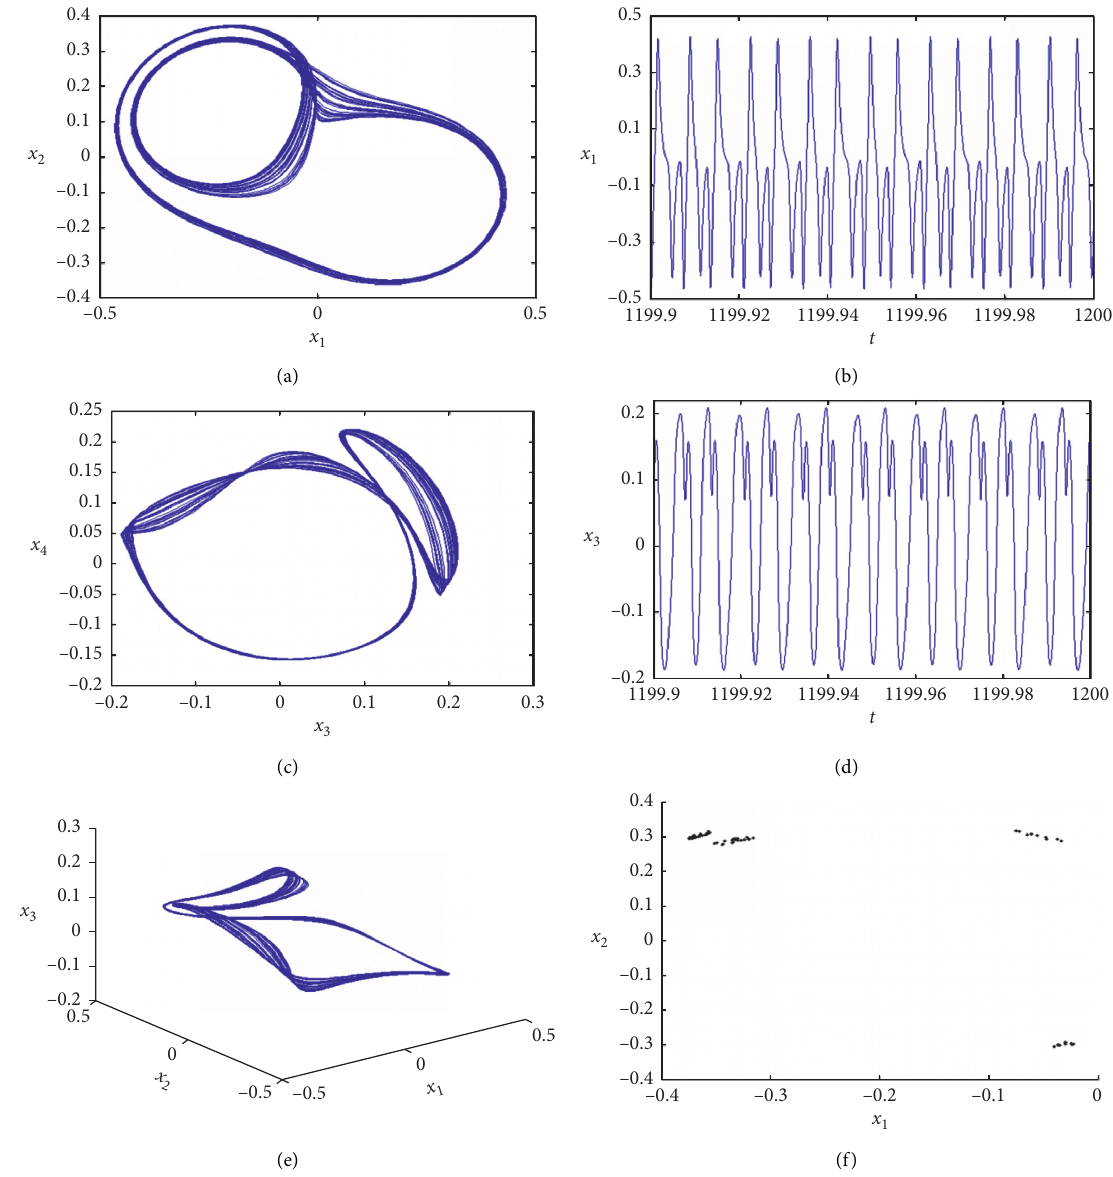
Figure 11: The multiperiodic oscillation of the cantilevered pipe conveying pulsating fluid is obtained when the parametric excitation of the � 23 . 2. (a) Phase portrait on plane ( x ,x ) , (b) waveform on plane ( t,x ) , (c) phase portrait on plane ( x , x ) , (d) flow velocity is U 0 1 2 1 3 4 ) , (e) three-dimensional phase portrait in space ( x ,x , x ) , and (g) Poincare map on plane ( x ,x ) waveform on plane ( t, x 3 1 2 3 1 2 pipe conveying pulsating fluid, as shown in Figure 15(b). It is from Figure 14 that the nonlinear oscillations of the can- also found from Figure 15(d) that, for the third-order mode, tilevered pipe conveying pulsating fluid also have the mo- there are twice-time nonlinear oscillations around the right- tions around the vertical equilibrium position. mode position and four-time nonlinear oscillations around Figure 15 indicates that the multitime periodic oscilla- the left-mode position. Figure 16 represents that the quasi- tion happens for the cantilevered pipe conveying pulsating periodic oscillation occurs when the external excitation is fluid when the external excitation is F � 4 . 5. For the first- F � 6 . 3. Figure 17 demonstrates that there exist the multi- order mode, four-time nonlinear oscillations occur around time chaotic oscillations of the cantilevered pipe conveying the right-mode position and twice-time nonlinear oscilla- pulsating fluid when the external excitation is F � 6 . 5. The tions occur around the left-mode position in the cantilevered